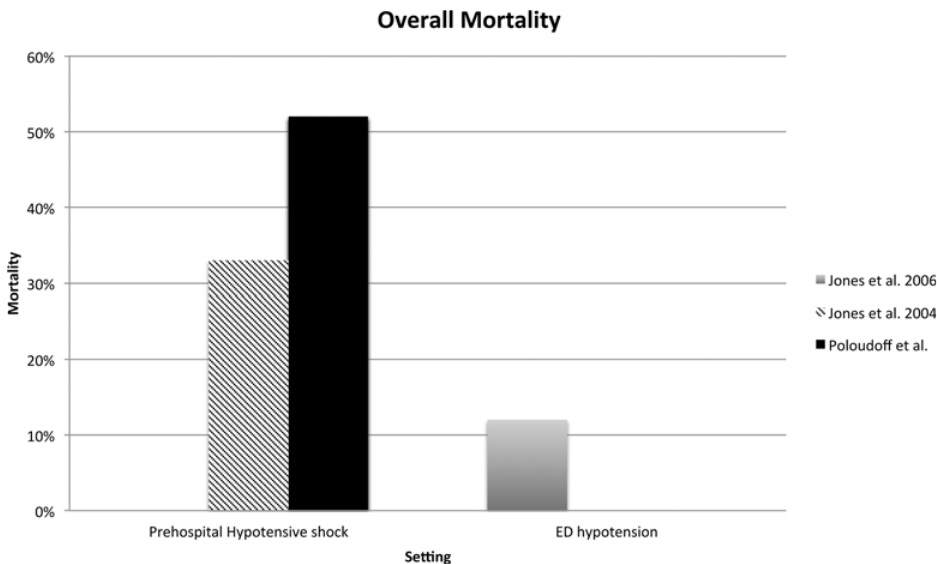
Fig 4. In-hospital mortality based on setting and presence of hypotension (Jones et al. 2006) and hypotensive shock (Poloudoff et al. and Jones et al. 2004).